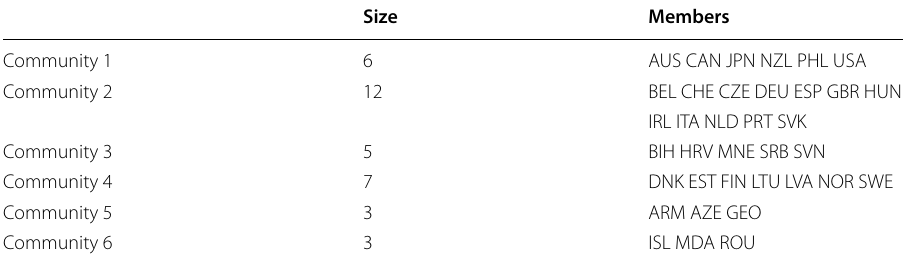
Table 5 Members of the six most populous communities in